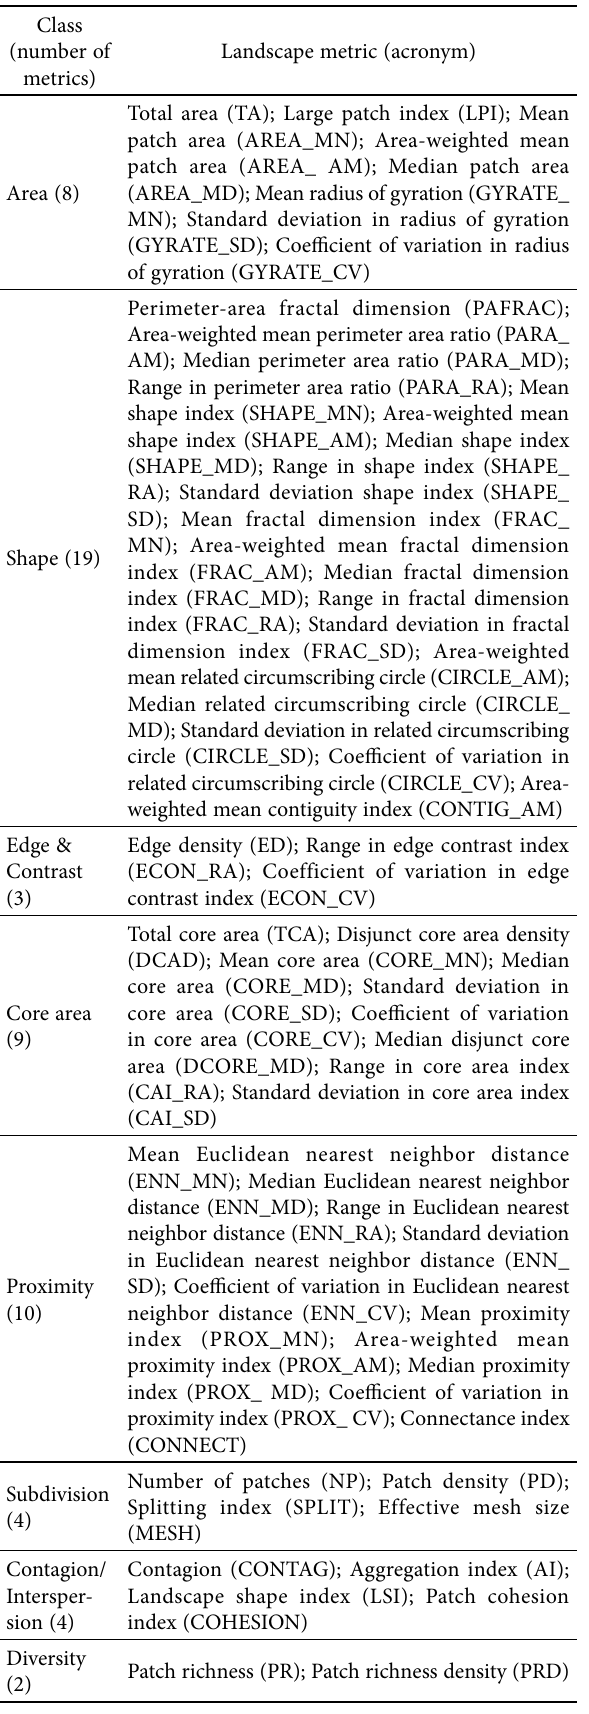
Table 2. Landscape metrics selected after data reduction